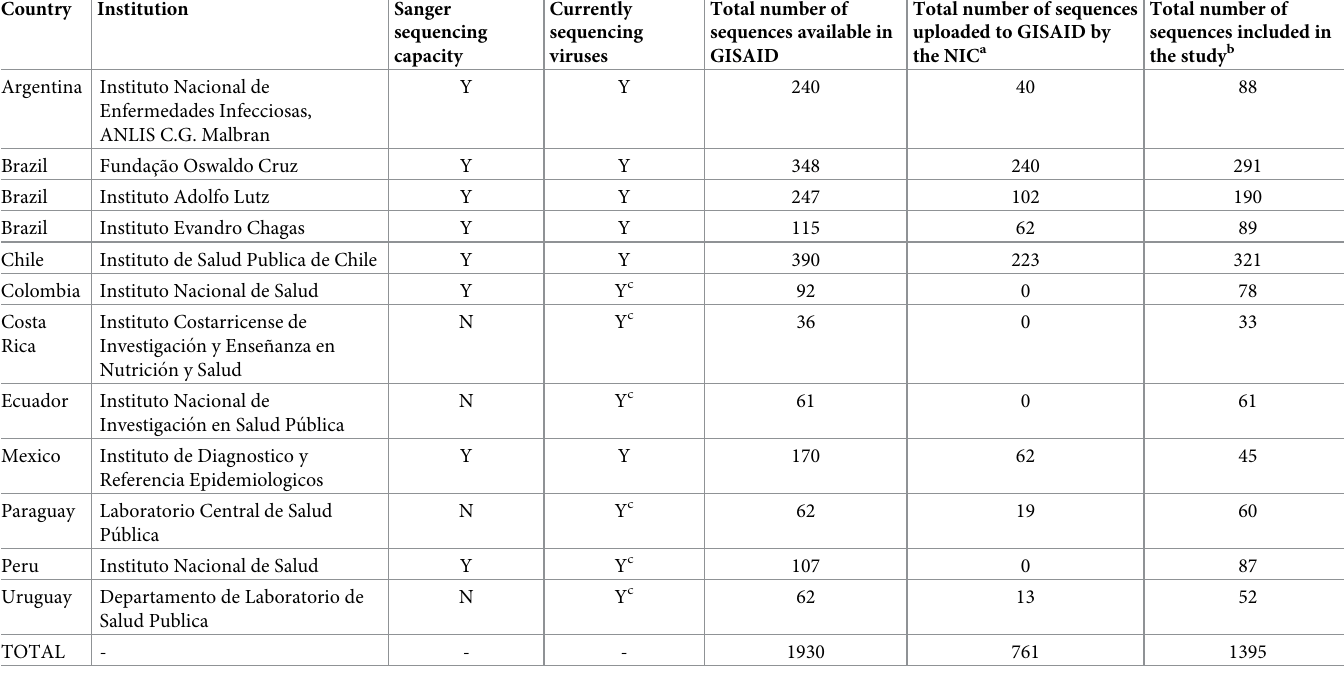
Table 1. Sequencing capacity and number of hemagglutinin (HA) genetic sequences available in GISAID—participating National Influenza Centres, May 1, 2017 to October 26,